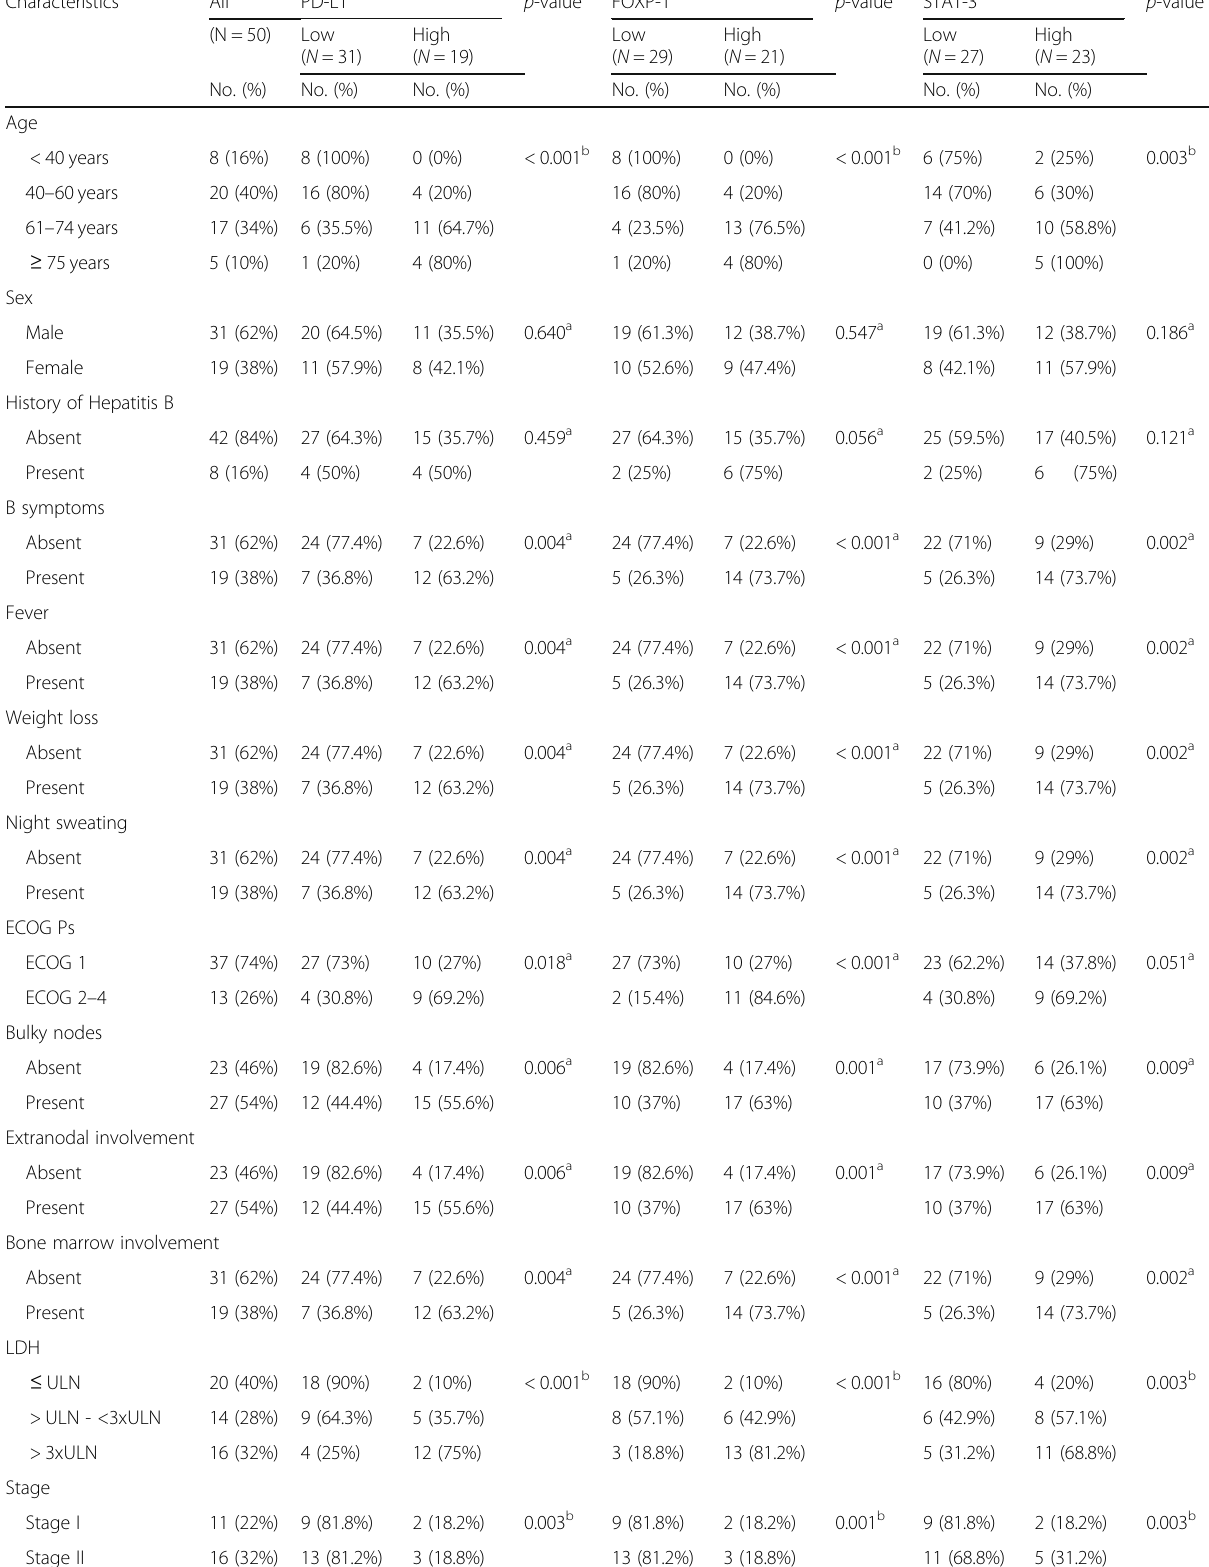
Table 2 Correlation between clinicopathological features, PDL-1, FOXP-1, STAT-3 expression in our patients